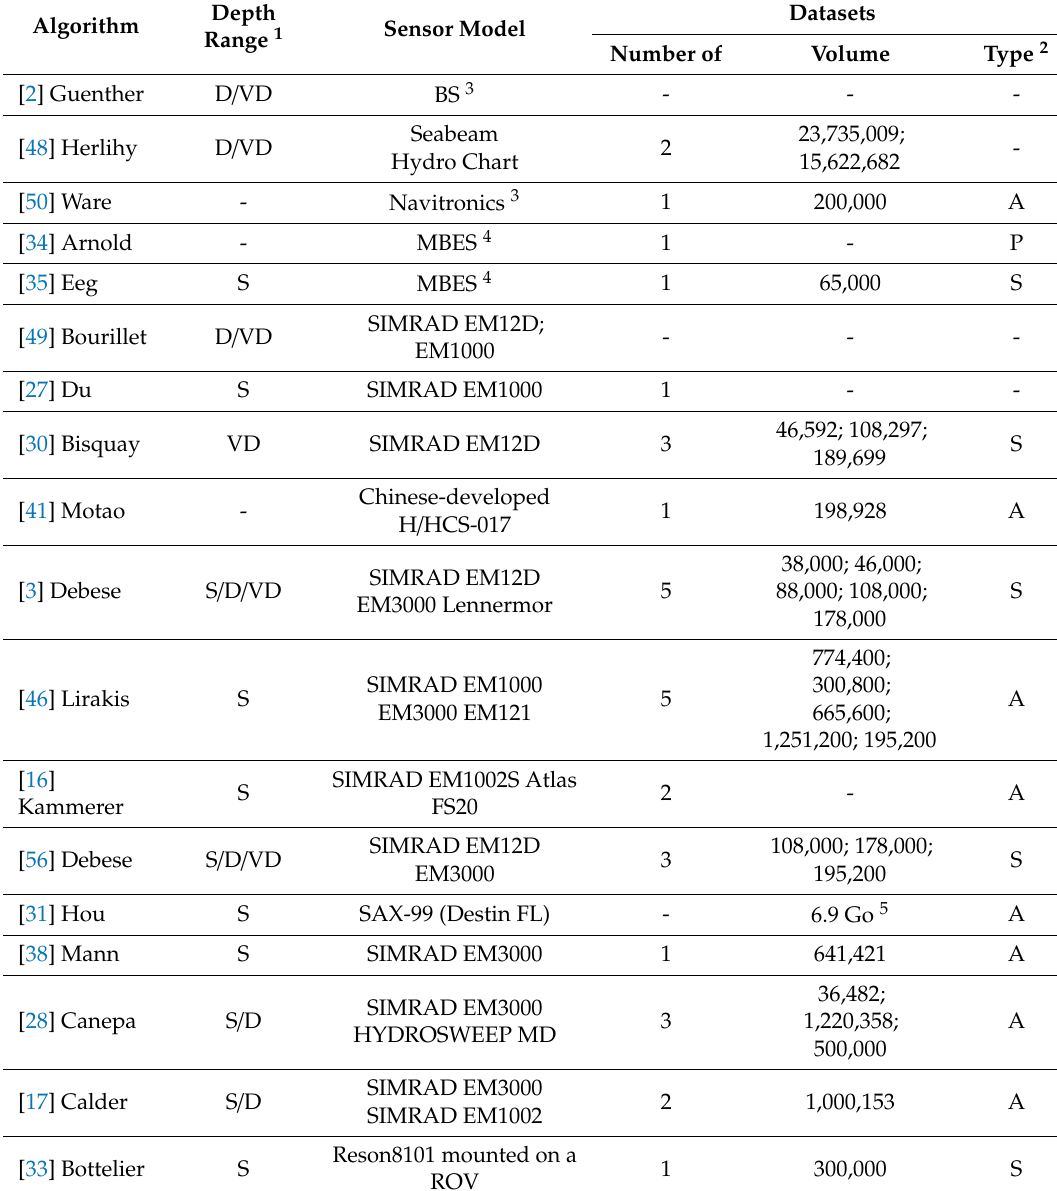
Table 4. Characteristics of real testing